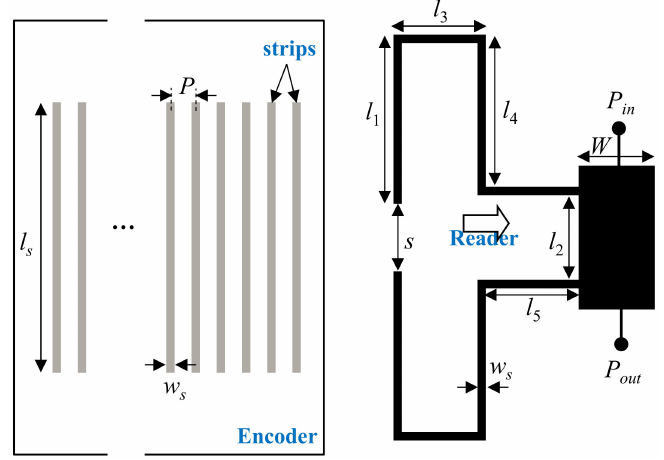
Figure 4. Topology of the encoder based on transversally oriented linear metallic strips, and topology of the reader, based on a pair of meandered stubs oriented face-to-face by the open ends (the arrow indicates the direction of motion). Reprinted with permission from [23]. Copyright 2019